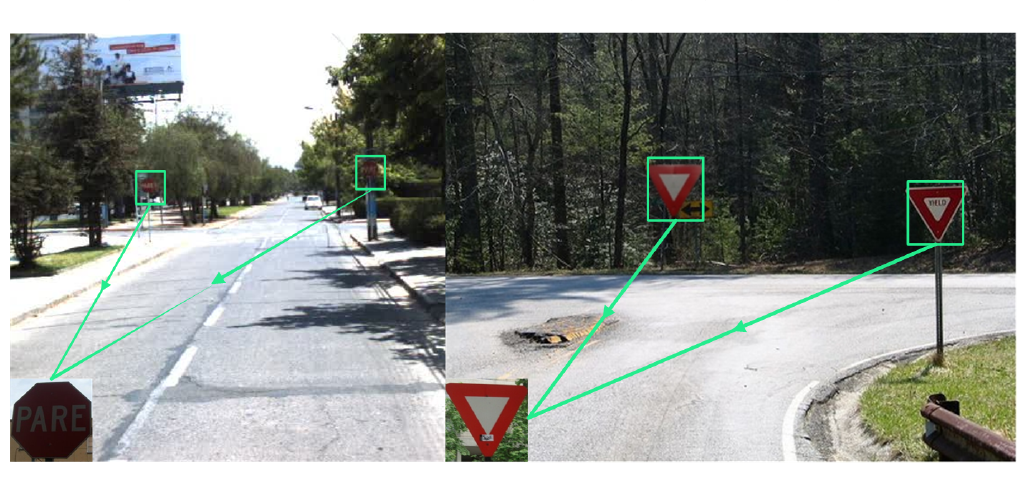
Figure 1. Examples of testing scenarios showing stop ( Left ) and yield ( Right ) signs near a road intersection and a